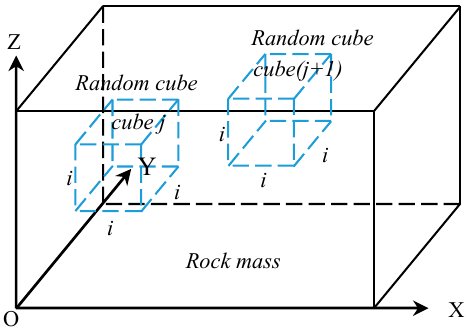
Figure 6. The randomly distributed cubes in a fractured rock mass.